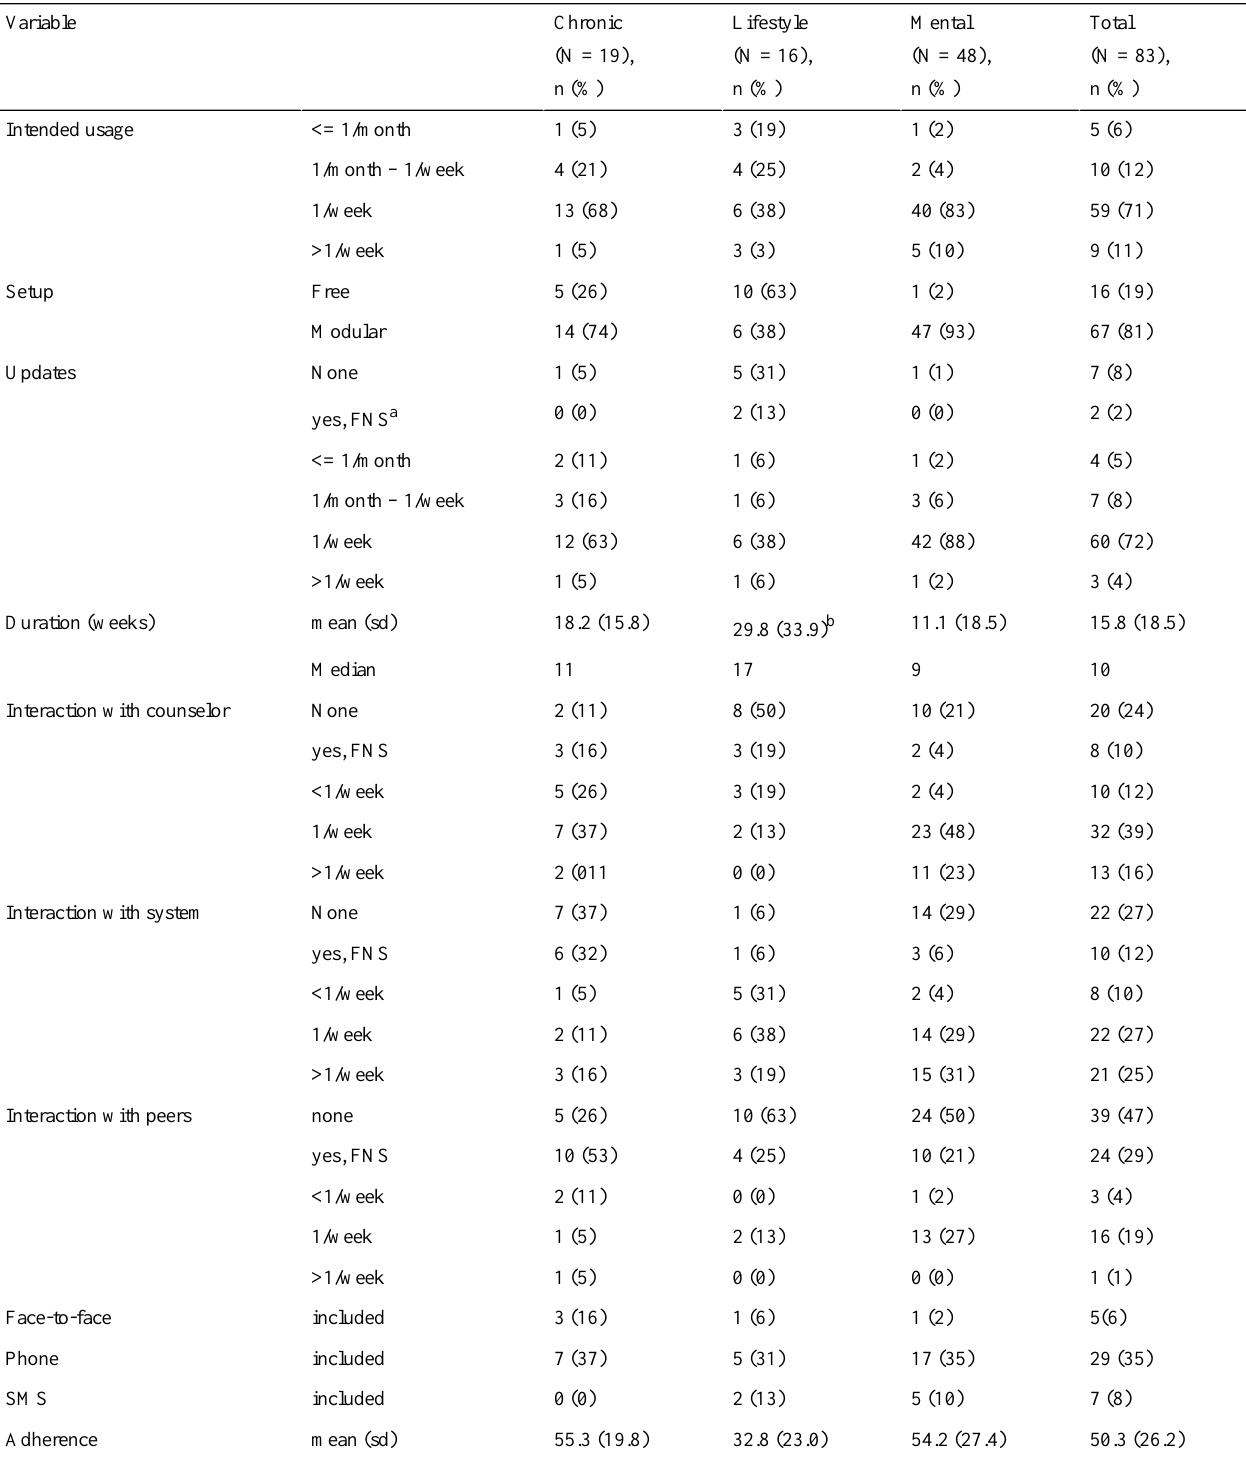
Table 2. Descriptive variables of the included interventions per health care